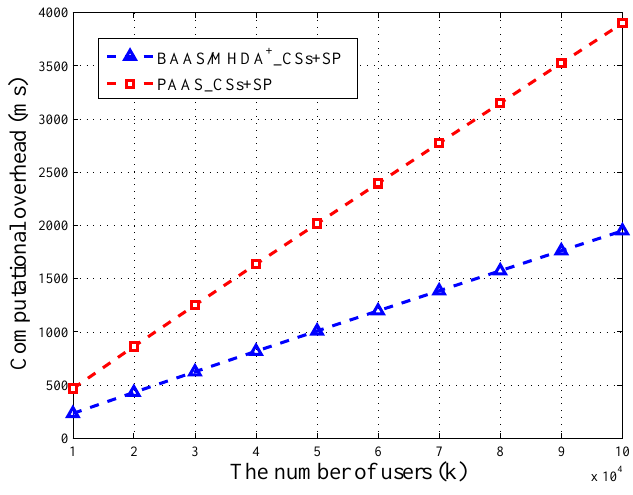
Figure 3. The computational overhead of BAAS, PAAS and MHDA +